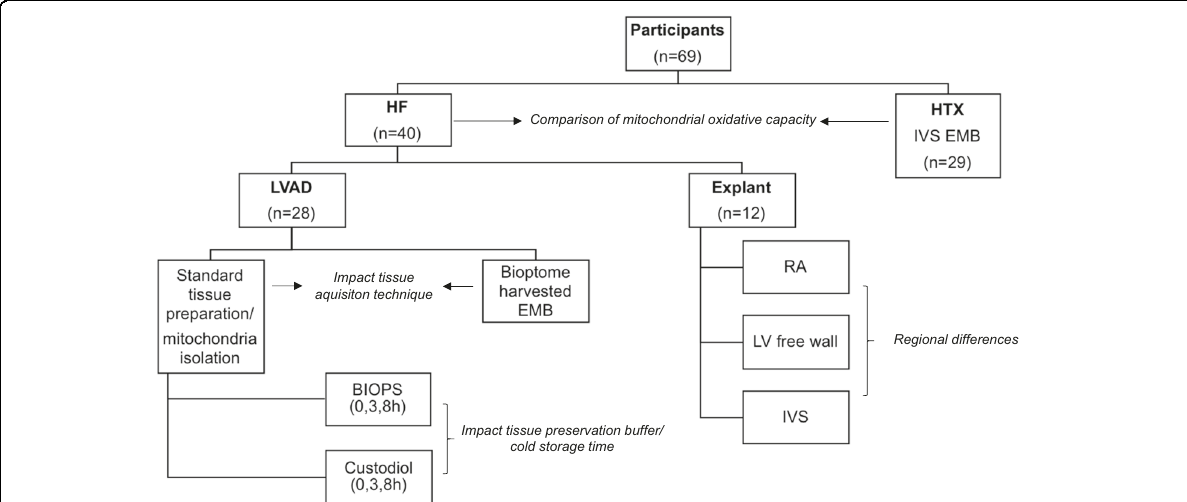
Fig. 1 Patient characteristics. The mitochondrial oxidative capacities in tissue specimens of HF patients and heart transplant recipients was compared. To assess the impact of the tissue acquisition technique on mitochondrial respiration, standard prepared tissues and ex vivo bioptome- harvested endomyocardial biopsies were compared to tissue specimens obtained during LVAD surgery. The impact of the tissue preservation buffer and cold storage time on mitochondrial respiration was analyzed in standard prepared tissues and isolated mitochondria from tissue specimens obtained during LVAD surgery. Heart explant tissue specimens were obtained from the RA, LV free wall, and IVS to analyze regional differences in mitochondrial respiration. HF patients suffering from terminal heart failure, HTX heart transplant recipients, IVS interventricular septum, LV left ventricle, LVAD left ventricular assist device, RA right